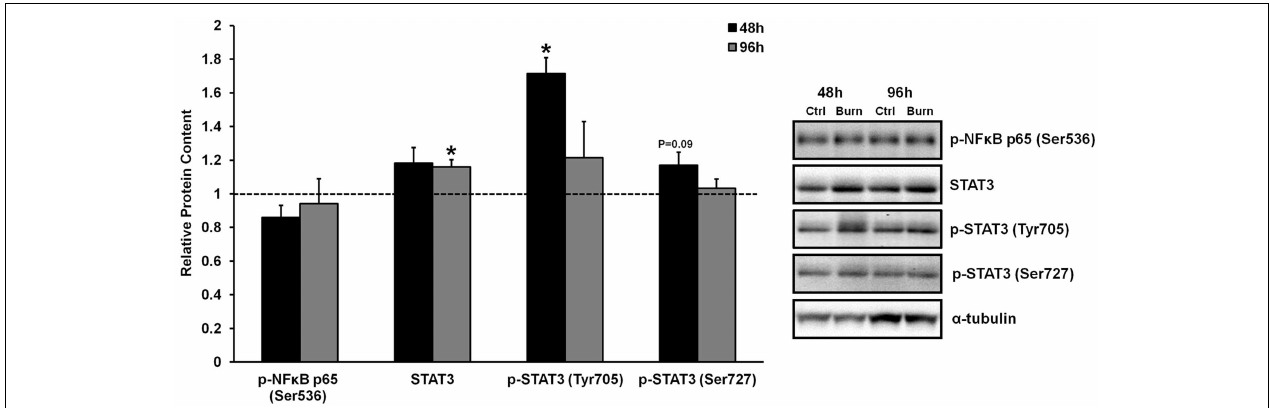
FIGURE 1 | Effects of burn serum on inflammatory NF κ B and STAT3 signaling. ∗ Different from control at respective time point; P < 0 . 05 . Dotted line represents control values. Representative blots for α -tubulin demonstrate equal loading between burn and control lanes.